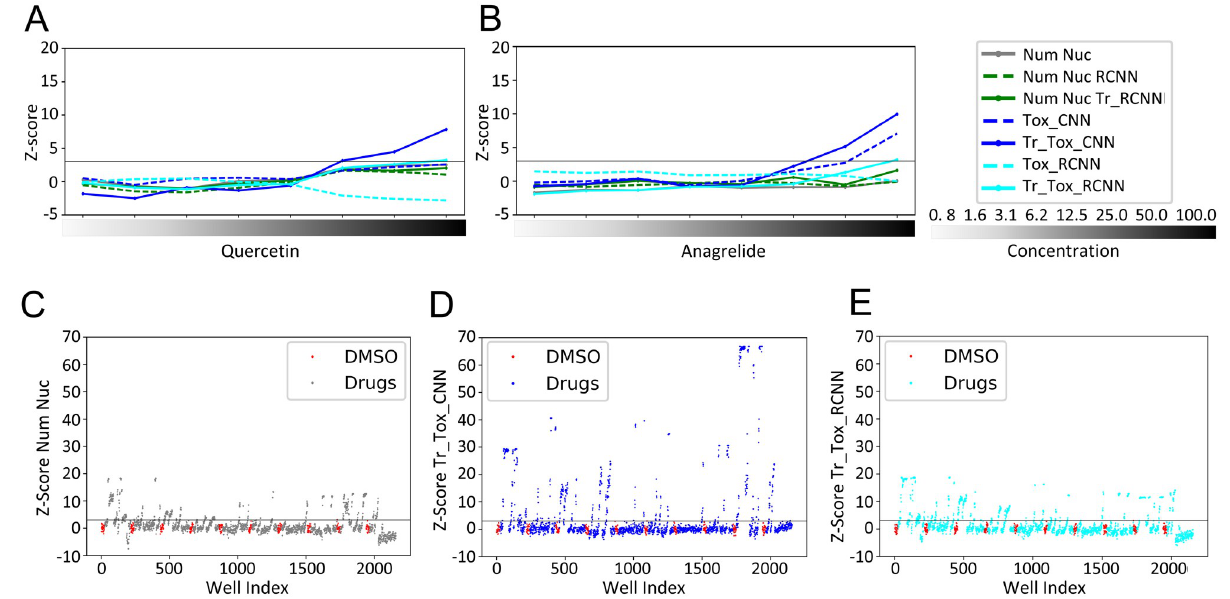
Fig 5. Validation of deep (R)CNN models for general drug toxicity screening. Pancreatic CAFs treated with 60 compounds or DMSO at the concentrations indicated ( μ M) (Experiments #15–24) were processed as described in the Materials and Methods. (A-B) Plots display mean toxicity readouts of replicate wells for quercetin (#19, A) and anagrelide (#33, B), obtained from the percentage of healthy cells predicted by the CNN Nuc (Tox_CNN) or RCNN (Tox_RCNN) mixed models before (dashed lines) and after (solid lines) transfer learning, and from nuclei counting by standard image segmentation (Num Nuc), or by using RCNN-based automated detection (Num Nuc RCNN) before (dashed lines) and after (solid lines) transfer learning. (C-E) Plots showing individual well toxicity readouts obtained after transfer learning from: nuclei counting using standard image segmentation (Num Nuc) (C), percentage of healthy cells predicted by CNN (Tr_Tox_CNN) (D), and percentage of healthy cells predicted by RCNN (Tr_Tox_RCNN) (E). Negative control, DMSO-treated wells, are highlighted in red. For each well, toxicity readouts were obtained by computing Z- scores (normalizing to DMSO-treated wells) with adjustment of the sign to display toxic effects as positive values.